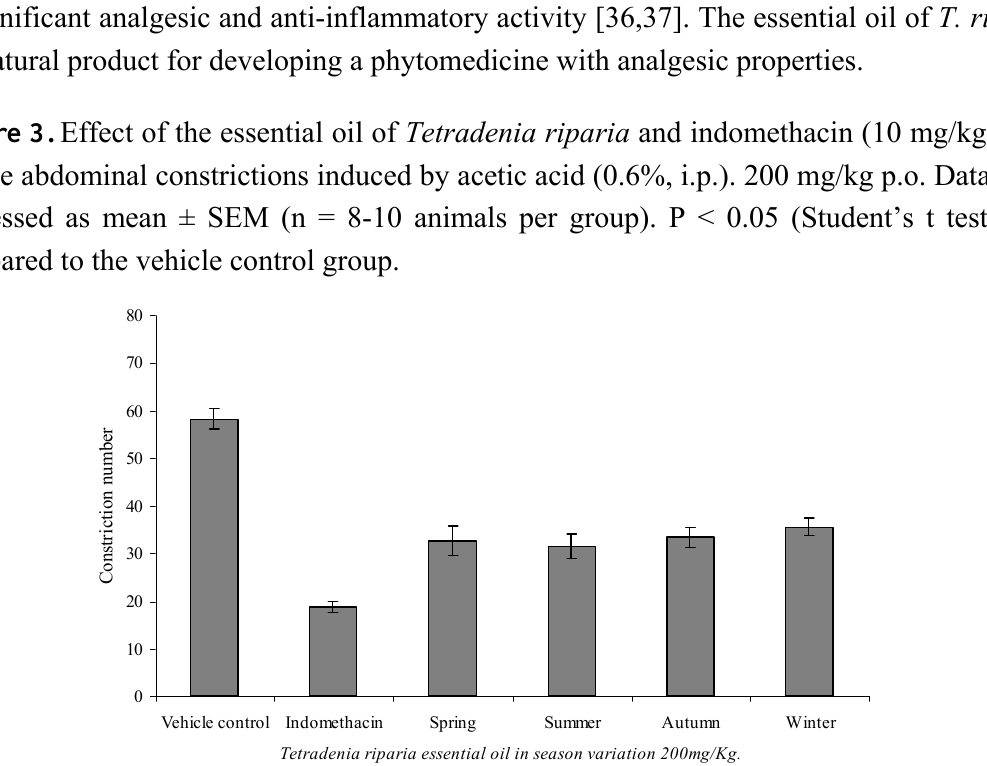
summer. Spring and summer samples were not discriminated from each other. In PC1, representing 69% of total data variability, the winter samples were separated from the others; while in